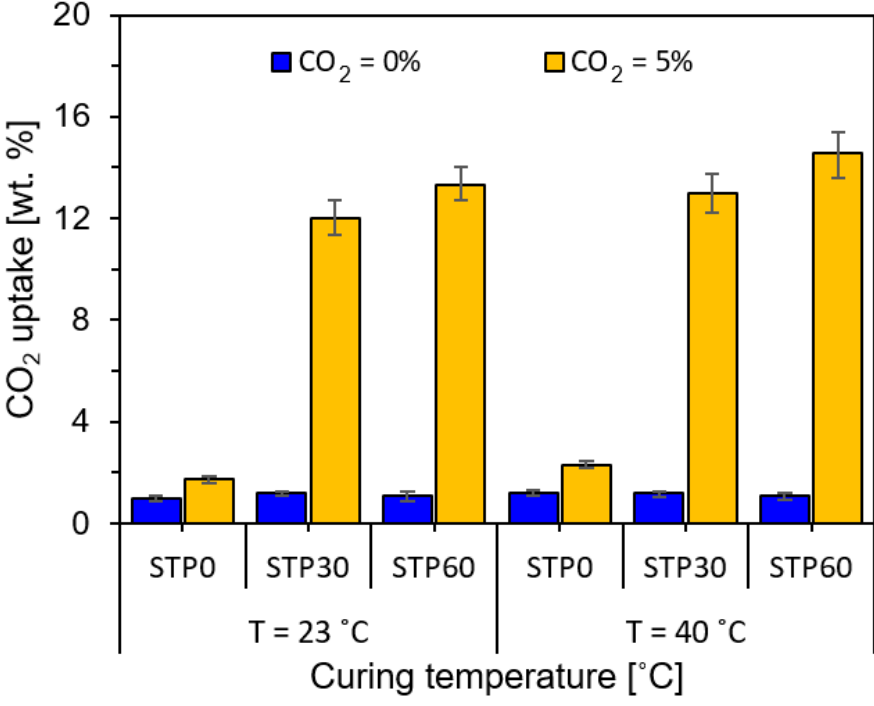
Figure 12. CO 2 uptake for specimens according to the curing temperature.